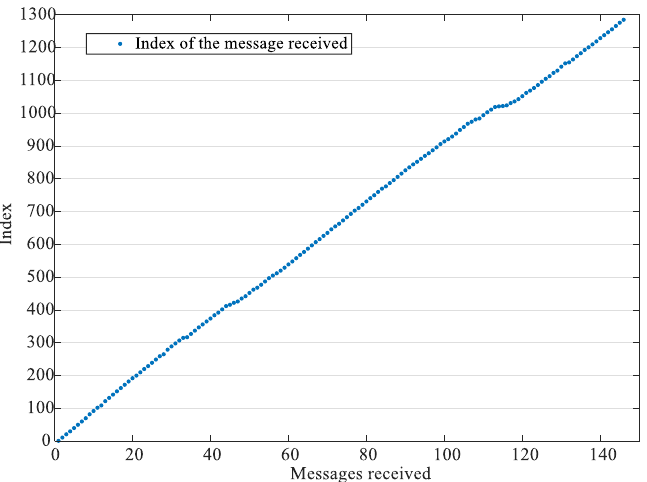
Figure 18. Index numbers of the received messages.